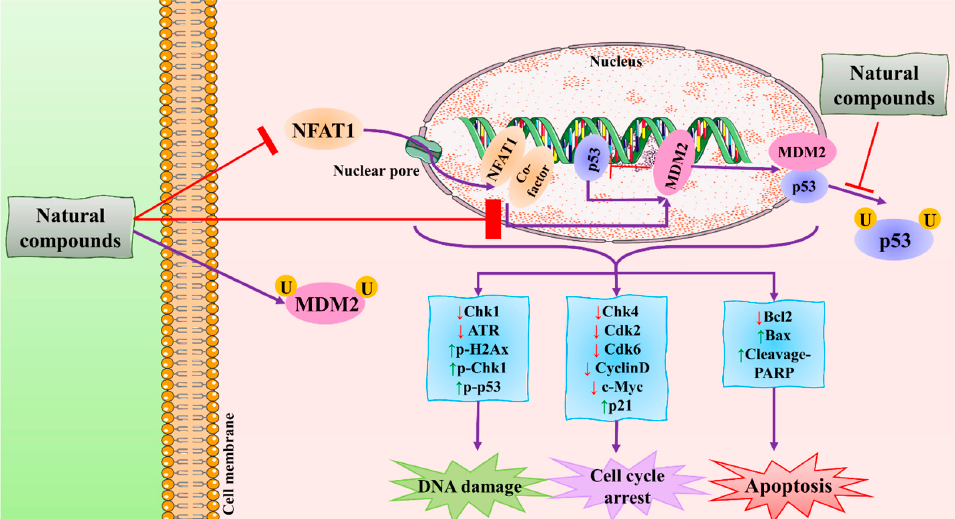
Figure 7. The schematic representation of the mechanism of action of natural compounds against BC using the MDM2 signaling pathway. Natural compounds induce apoptosis by inhibiting the NFAT1-MDM2 signaling pathway to reduce cancer. NFAT1: nuclear factor of activated T cells 1; MDM2: mouse double minute 2 homolog; CDK: cyclin-dependent kinase; Chk: checkpoint kinase; Bcl-2: B-cell lymphoma 2; Bax: BCL2-associated X protein; PARP: poly (ADP-ribose) polymerase.